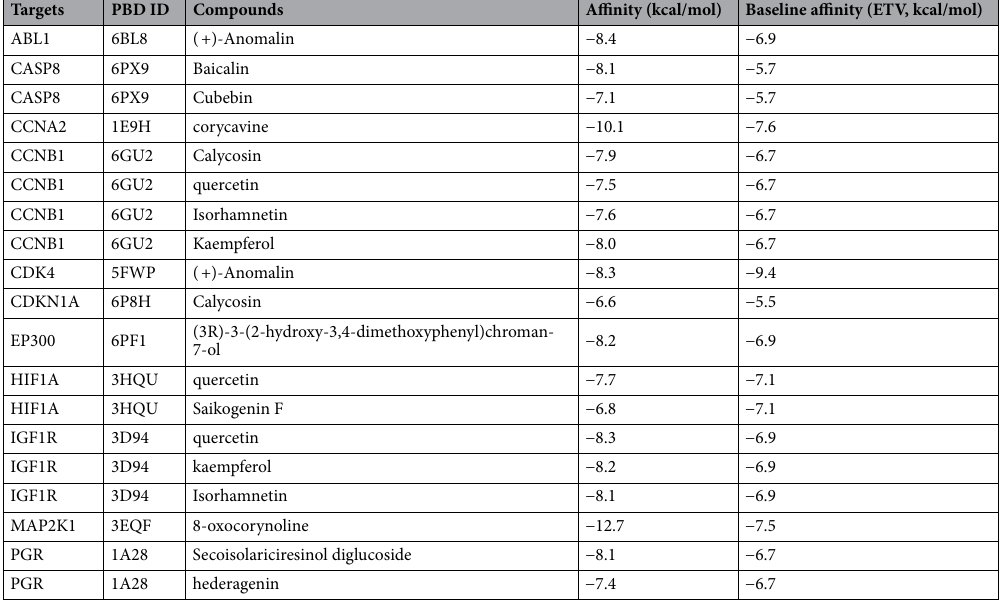
Table 1. The docking scores of key compounds and key target